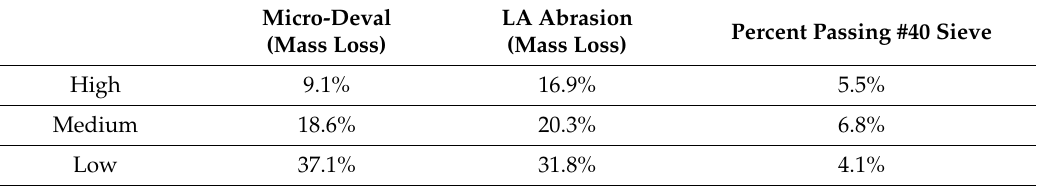
Table 1. Mean values of the material test results.